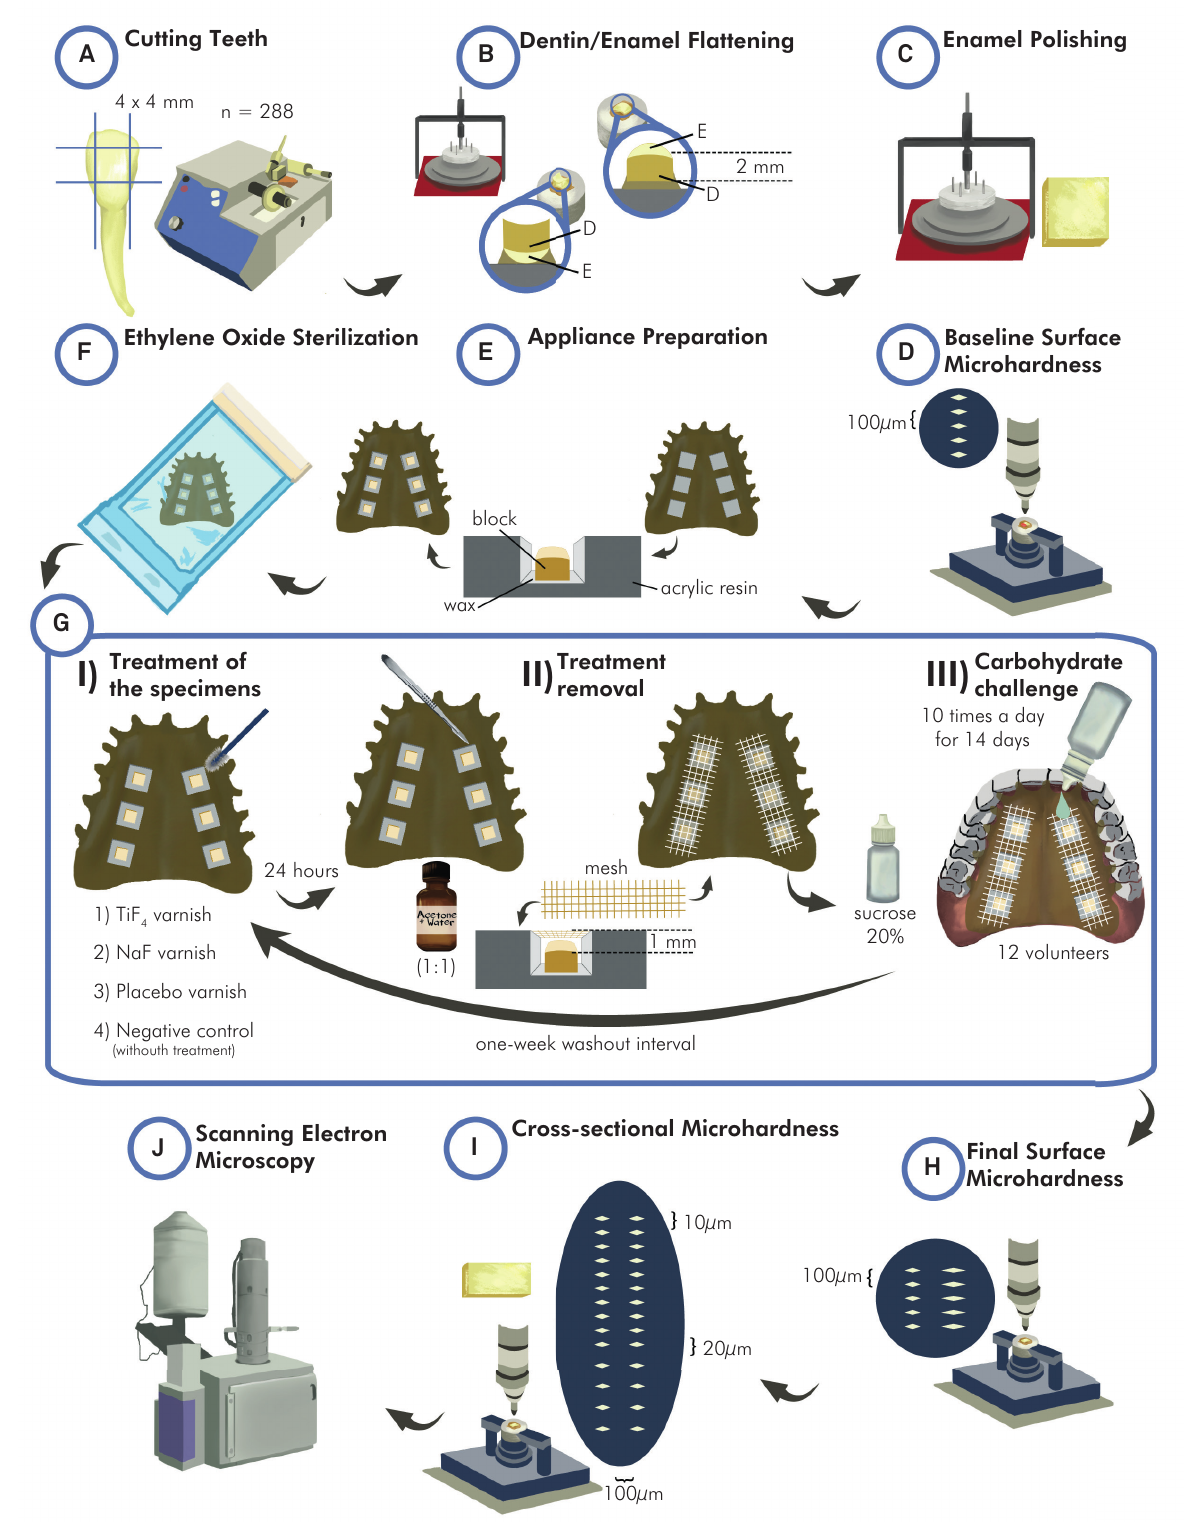
Figure 1. Schematic diagram of process steps: A - Cutting Teeth; B – Dentin/Enamel Flattening; C - Enamel Polish; D - Baseline Surface Microhardness; E – Appliance Preparation; F – Ethylene Oxide Sterilization; G (I) – Treatment of the Specimens, (II) – Treatment Removal, (III) – Carbohydrate challenge; H - Final Surface Microhardness; I – Cross-sectional Microhardness; J -Scanning Electron Microscopy.